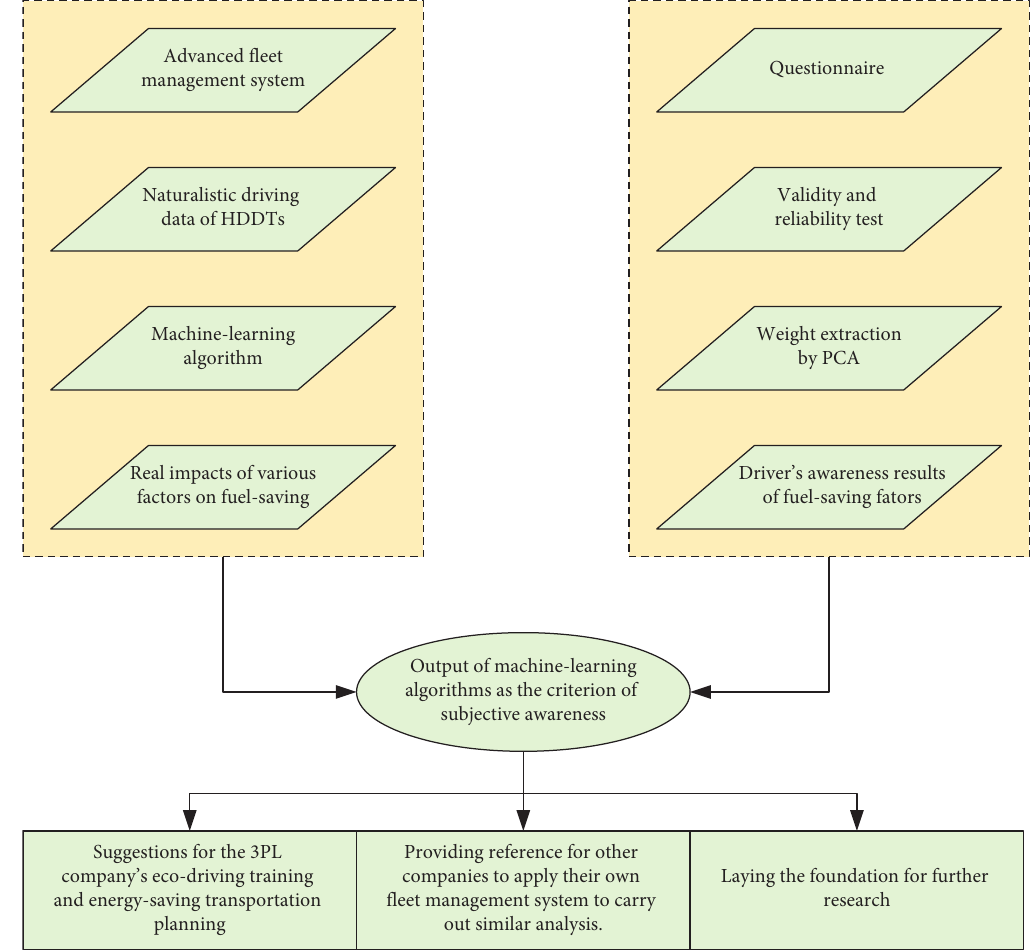
Figure 2: The framework of this study.